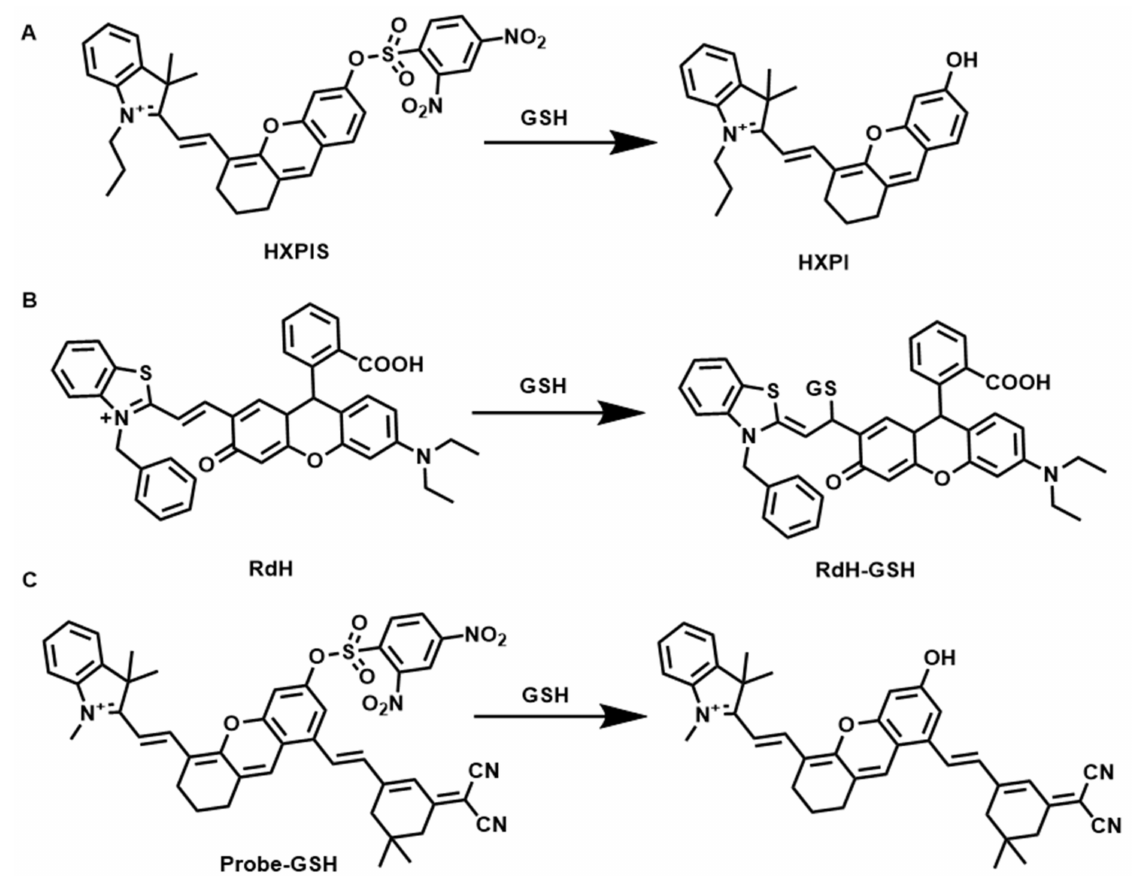
Figure 14. The response mechanisms and chemical structures ( A ) HXPIS, ( B ) RdH, and ( C ) Probe- GSH of fluorescent probes for